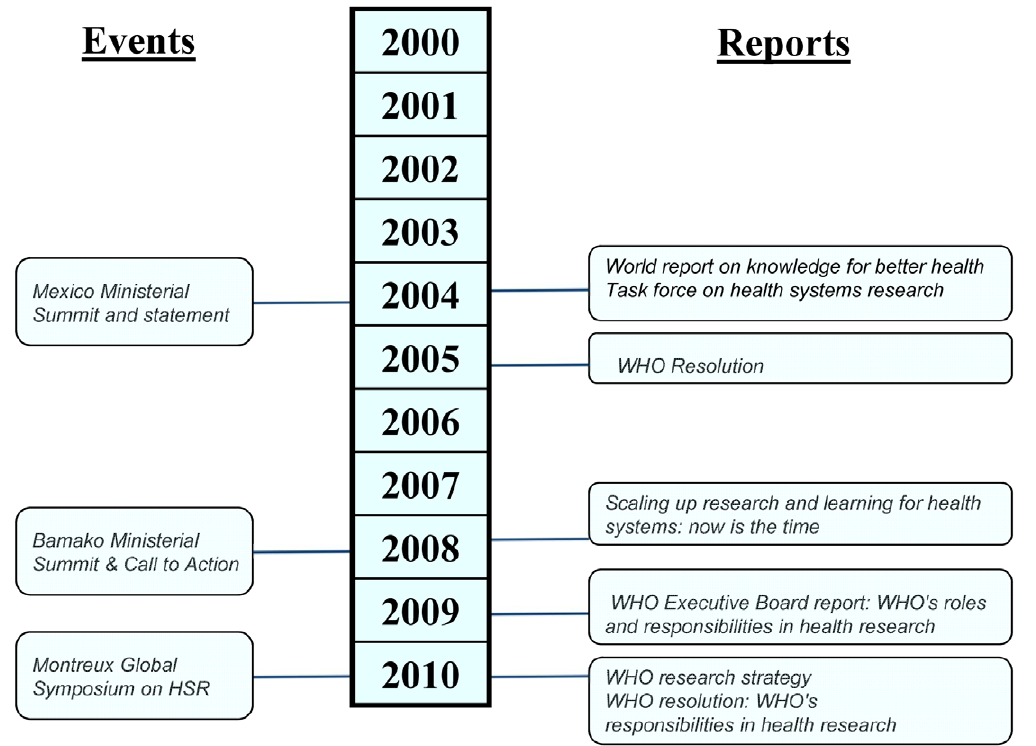
Figure 1. Timeline of major events or reports related to HPSR between 2000–2010.